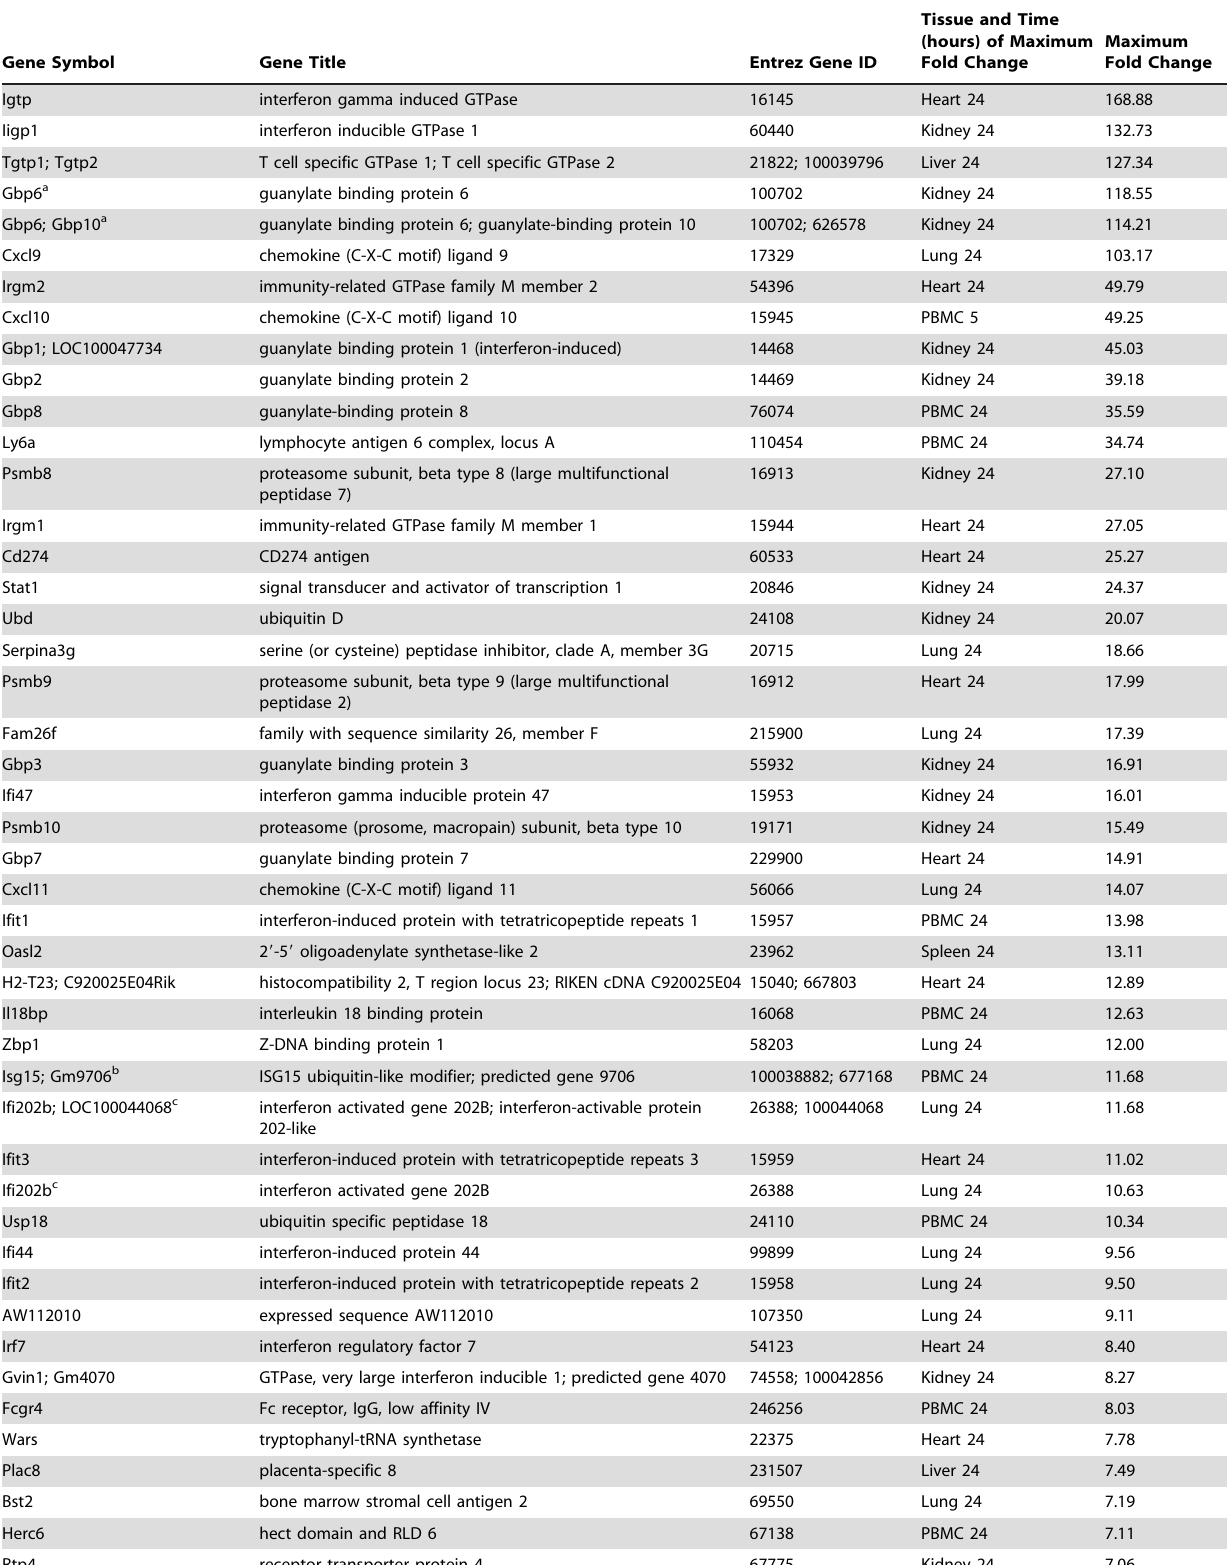
Table 3. Eighty-five annotated genes were up-regulated in all six tissues.